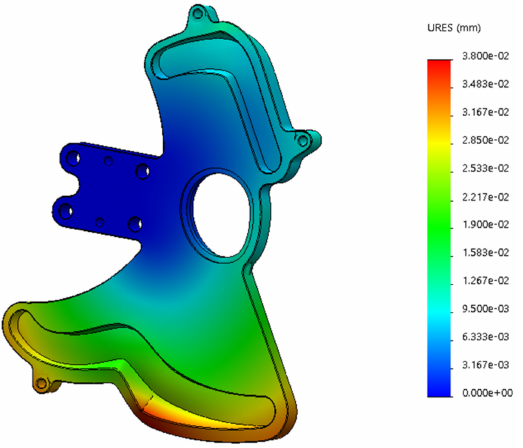
Figure 18. Stress analysis of the guide plate with the contact force exerted at the location of the guide pins for the knee angle of 161 ◦ .